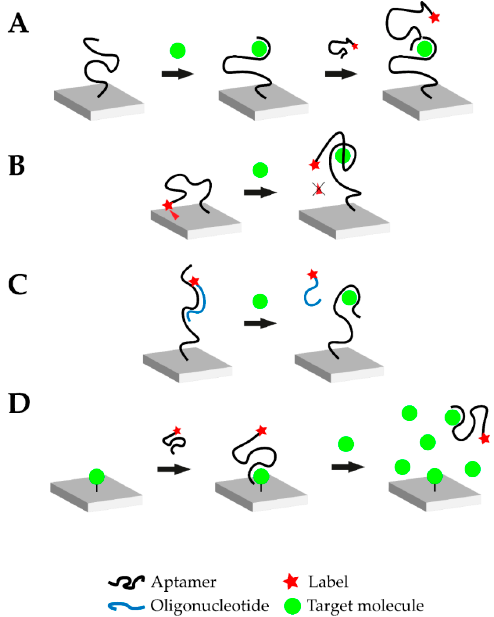
Figure 1. Overview of the di ff erent possible operational modes of aptasensors. ( A ) Sandwich or sandwich-like mode: One aptamer is immobilized on a surface and the target molecule is